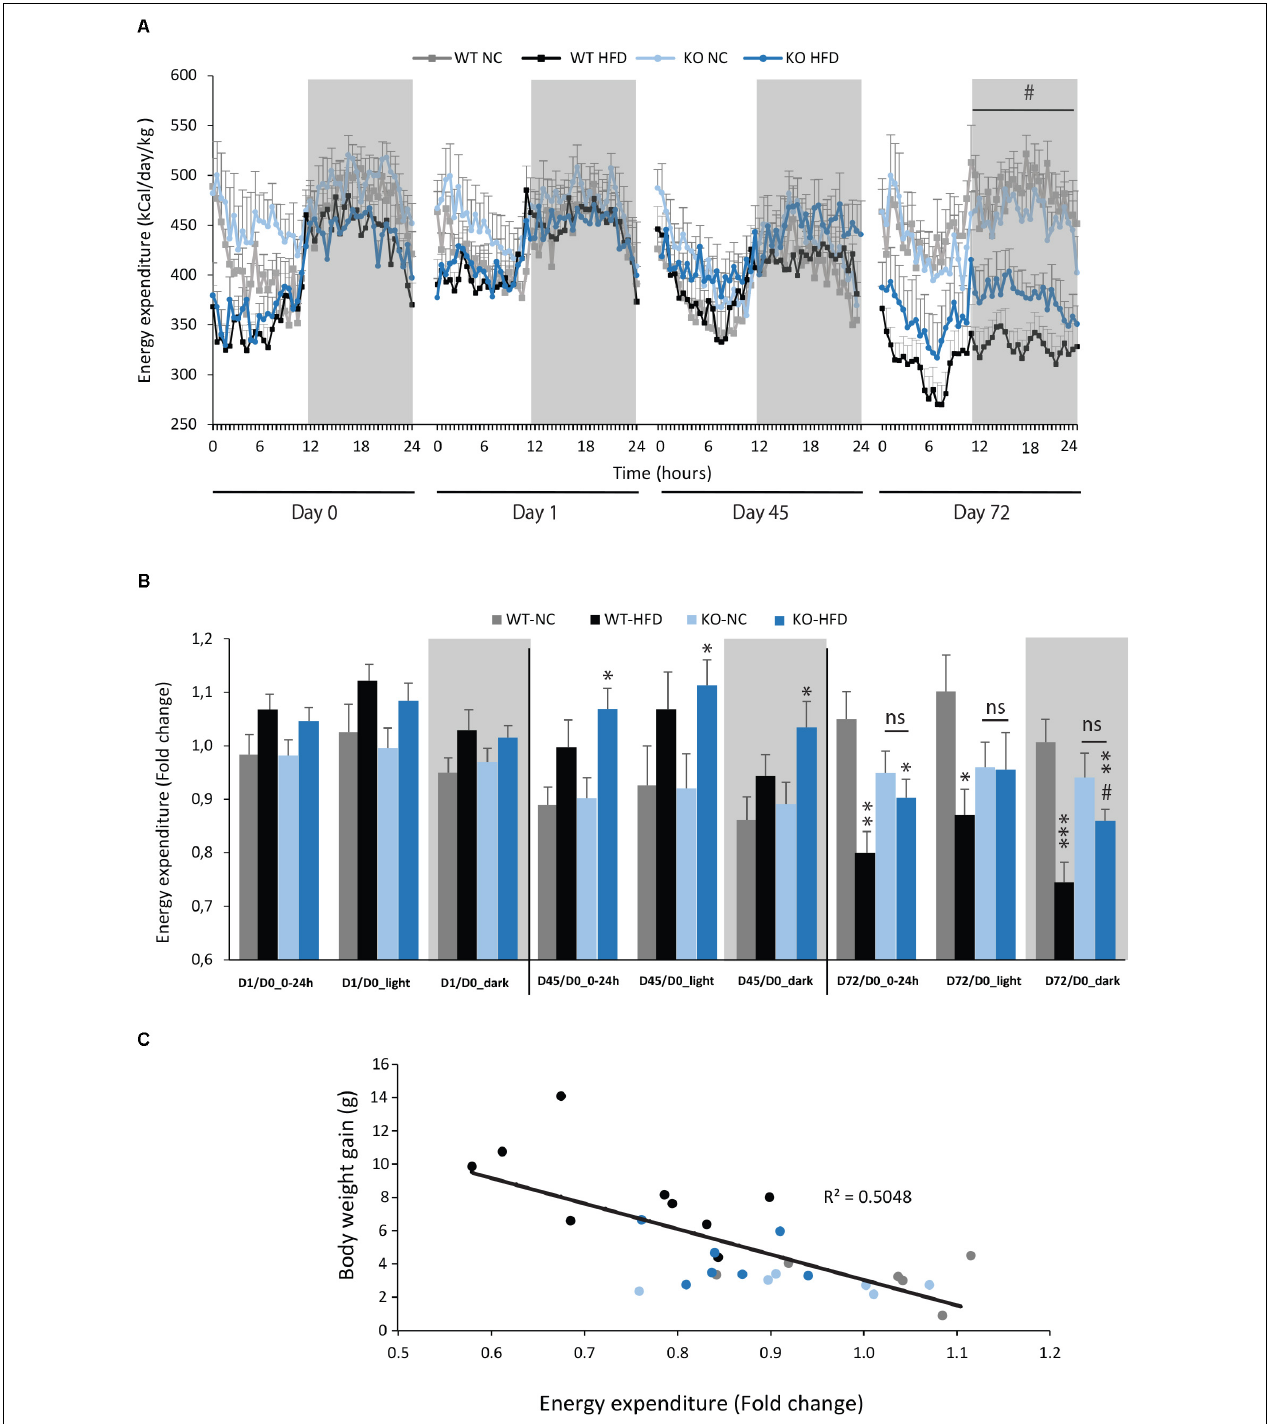
FIGURE 7 | mPGES-1 − / − mice maintained their energy expenditure during HFD feeding. Energy expenditures (EE, kcal/day/kg) of WT and KO mice fed with either normal chow (NC) or a high-fat diet (HFD) were calculated from data obtained by indirect calorimetry. Data were acquired at three different time points ( A ; D1, D45, and D72). Mean total EE for light phase, dark phase, and the entire day were compared to baseline data obtained for each animal at the beginning of the experiment and expressed in fold changes (B) . A quantification of daytime and nighttime EE revealed significant differences between WT-HFD and KO-HFD mice. (C) Correlation analysis was performed on energy expenditures and body weight of WT and KO mice fed either with NC or HFD ( R 2 = 0.503 ). Data shown are mean ± SEM. ∗ , significantly different from WT-NC; # , significant difference between WT-HFD and KO-HFD; ∗ p < 0.05; ∗∗ p < 0.01; ∗∗∗ p < 0.001; same statistical parameters apply to # symbol; and ns, not